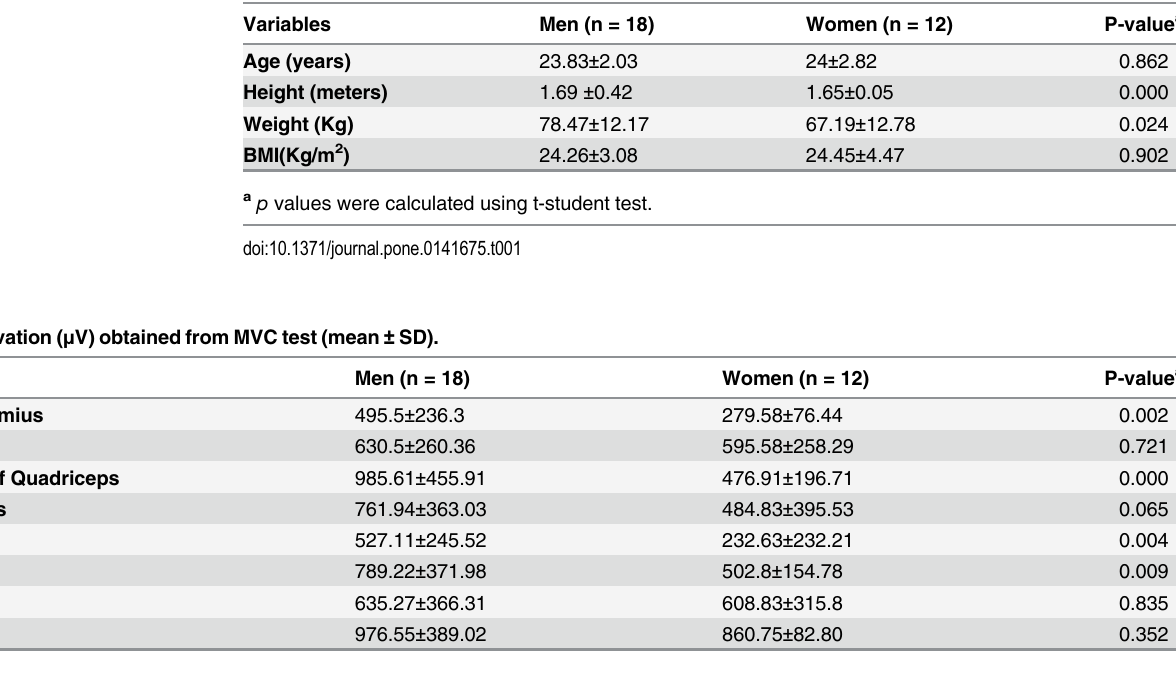
Table 1. Descriptive and anthropometric variables in men and women (Mean ± SD).